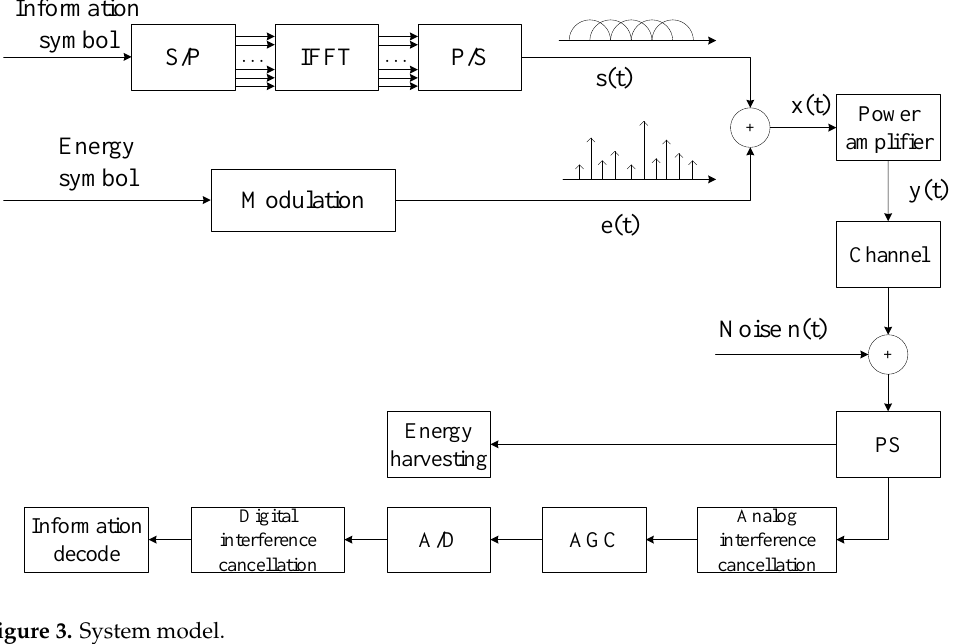
Figure 3. System